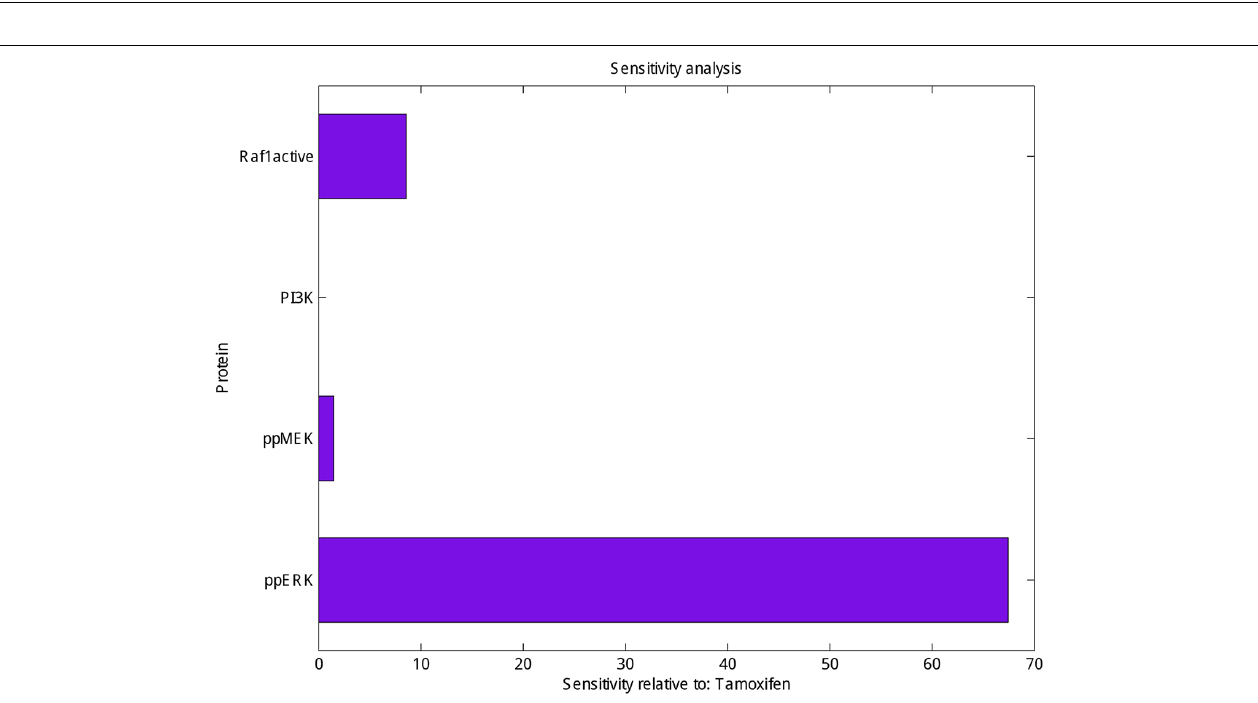
FIGURE 3 | Sensitivity analysis of Raf1 active, PI3K, ppMEK and ppERK. Calculation the sensitivity of Raf1 active, PI3K, ppMEK and ppERK ( X -axis) with respect to tamoxifen ( Y -axis) which represented the highest sensitivity for ppERK.